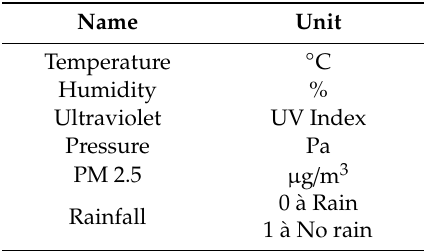
Table 3. The unit of each sensor.